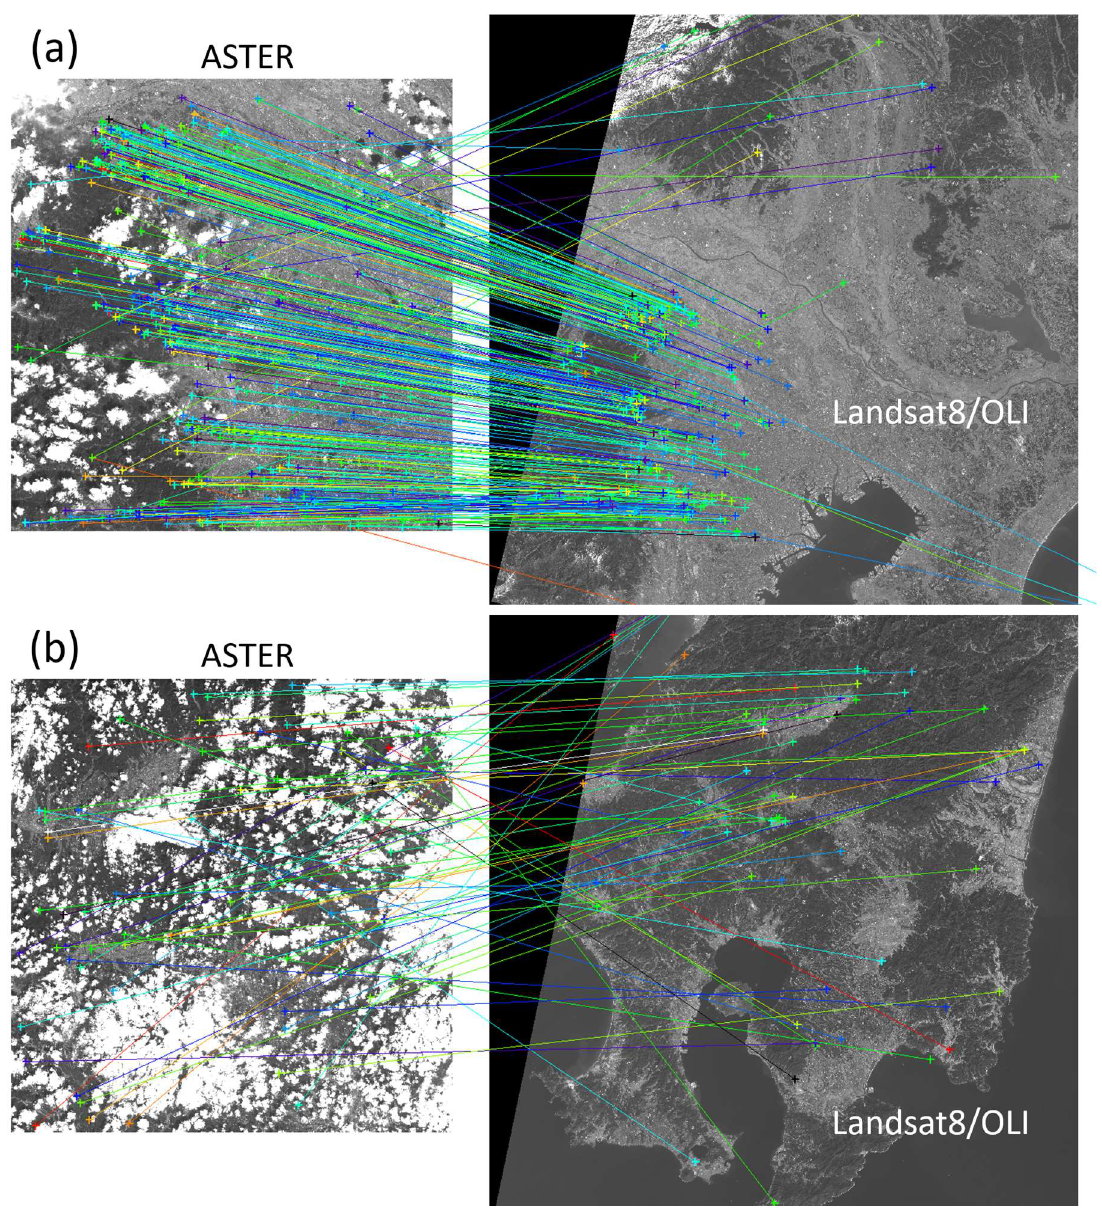
Figure 3. Examples of feature extraction and rough matching for ( a ) few clouds (Kanto, Japan) and ( b ) many clouds (Kyushu, Japan) by using SURF algorithm, which includes both correctly and incorrectly matched pairs. Left and right panels are raw image from ASTER observation and map-projected image from Landsat OLI, respectively. “+” represent locations of detected SURF features, and lines connect pairs of corresponding features in two images. Line color represents relative similarity of paired features (blue to red in order of increasing similarity) measured as distance of SURF descriptors between these features.